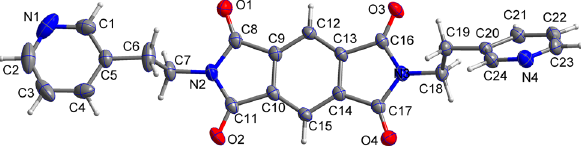
Table  : Data collection and